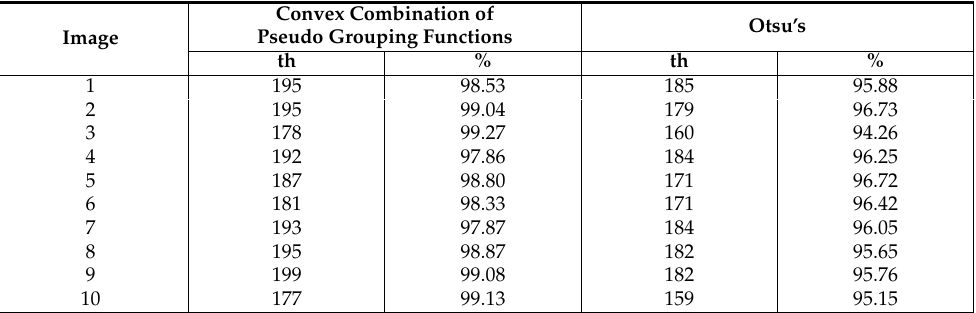
Table 14. Thresholds and percentages obtained from presented algorithm as well as Otsu’s algorithm. Convex Combination of Pseudo Grouping Image